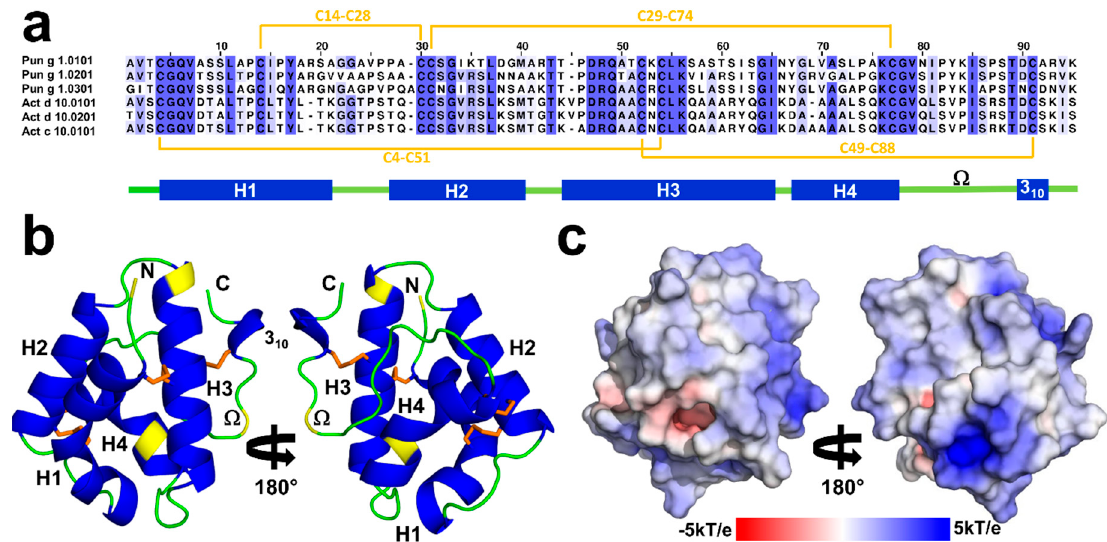
Figure 1. ( a ) Sequence alignment of non-specific lipid transfer proteins (nsLTPs) originating from pomegranate and kiwifruits. Disulfide bridges observed in Act c 10.0101 are marked in orange. Secondary structure elements are indicated below the sequence alignment. Helices are shown in blue and loops in green. Yellow color indicates residues that are different between Act c 10.0101 and Act d 10.0101 or Act d 10.0201. ( b ) Cartoon representation of Act c 10.0101 shown in two different orientations. Disulfide bridges are marked in orange. ( c ) Surface representation of Act c 10.0101 showing distribution of charges.